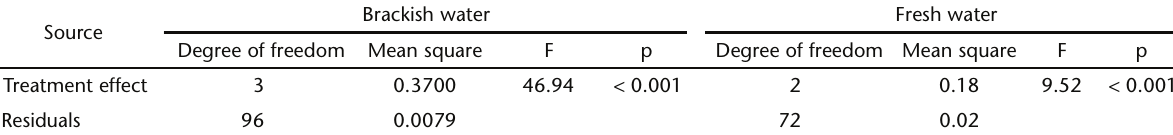
Table I. One-way ANOVA summary comparing treatments for the ratio between peristome width and 6 th setiger width in brackish and fresh water.